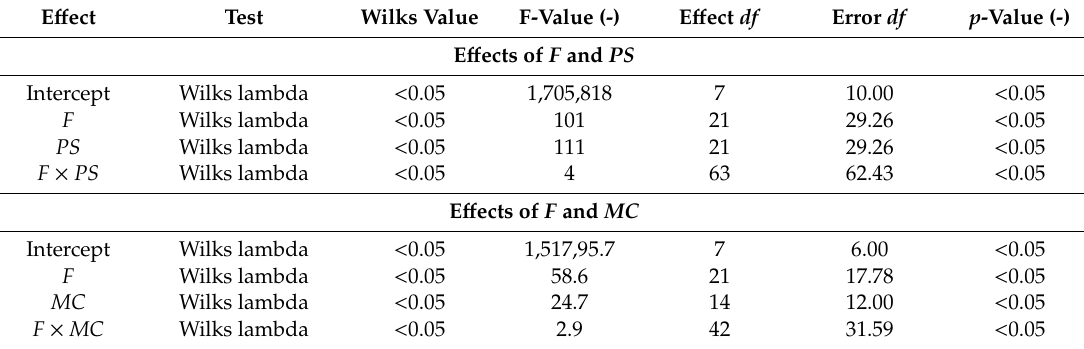
Table 9. ANOVA multivariate tests of significance of parameters of ground hazelnut husk